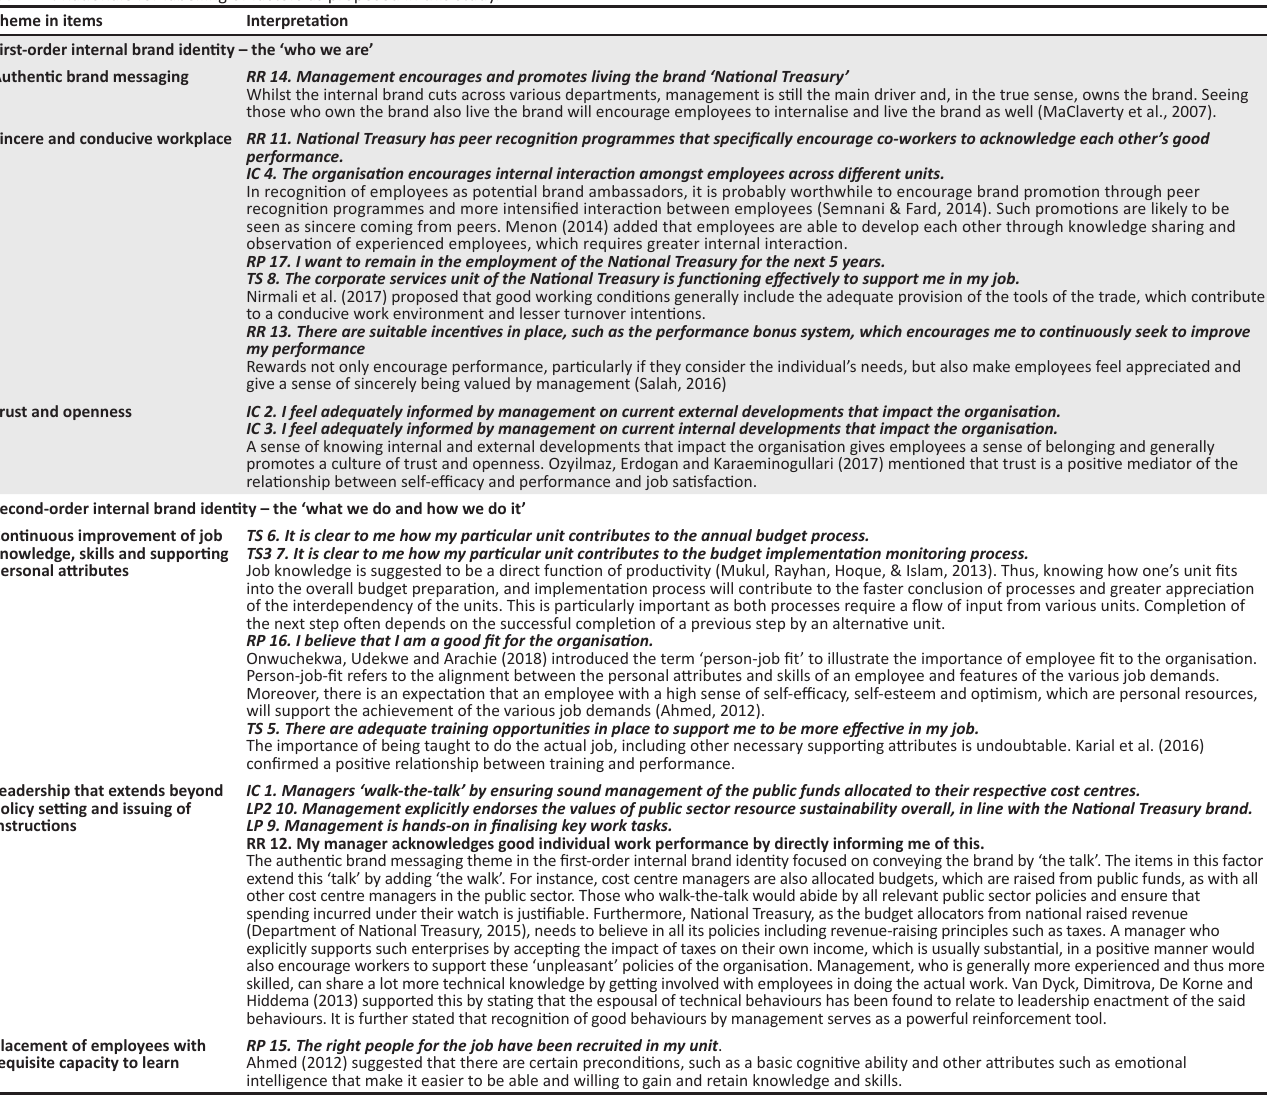
TABLE 1: Rationale for labelling of factors as proposed in this